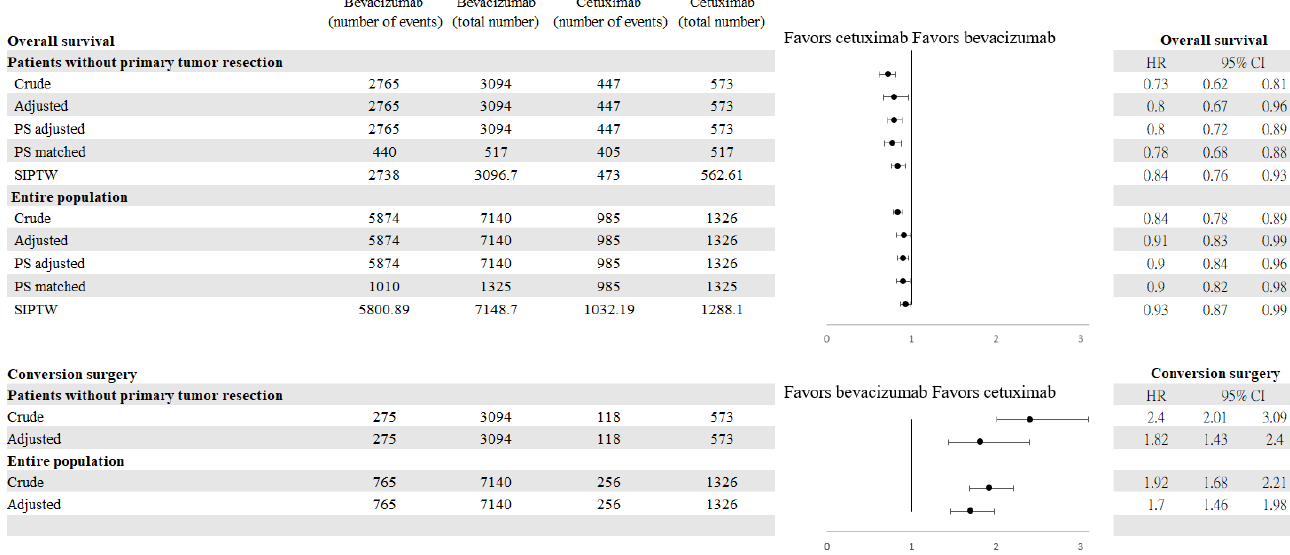
Figure 3. HRs of OS and conversion surgery among patients who did not undergo PTR and in the overall population; bevacizumab versus cetuximab. CI, confidence interval; HR, hazard ratio; OS, overall survival; PS, propensity score; PTR, primary tumor resection; SIPTW, stabilized inverse probability of treatment weights. Table 2. Interaction between primary tumor resection and targeted therapy in terms of overall survival for